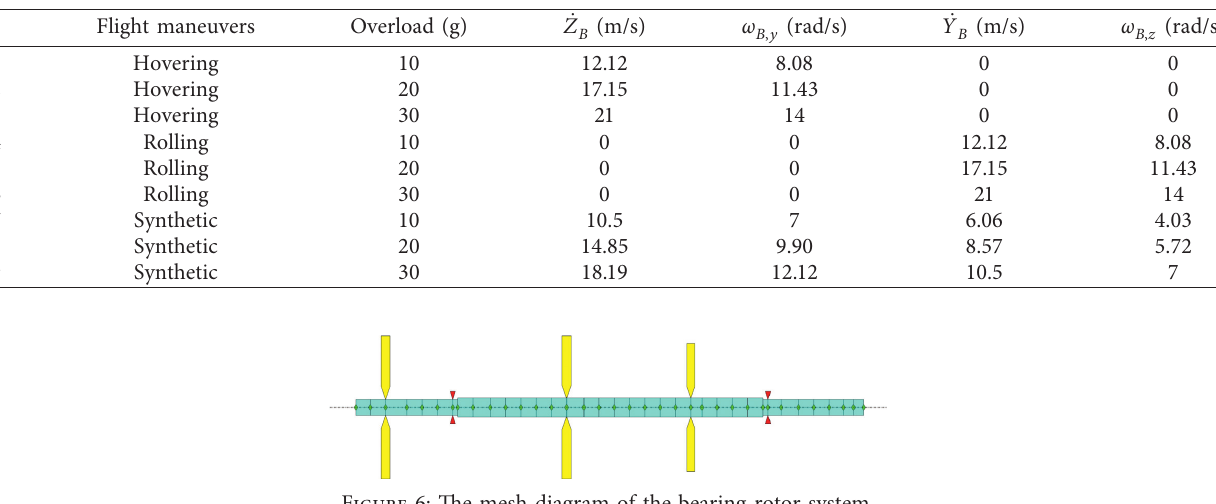
Table 3: Maneuver flight parameters.